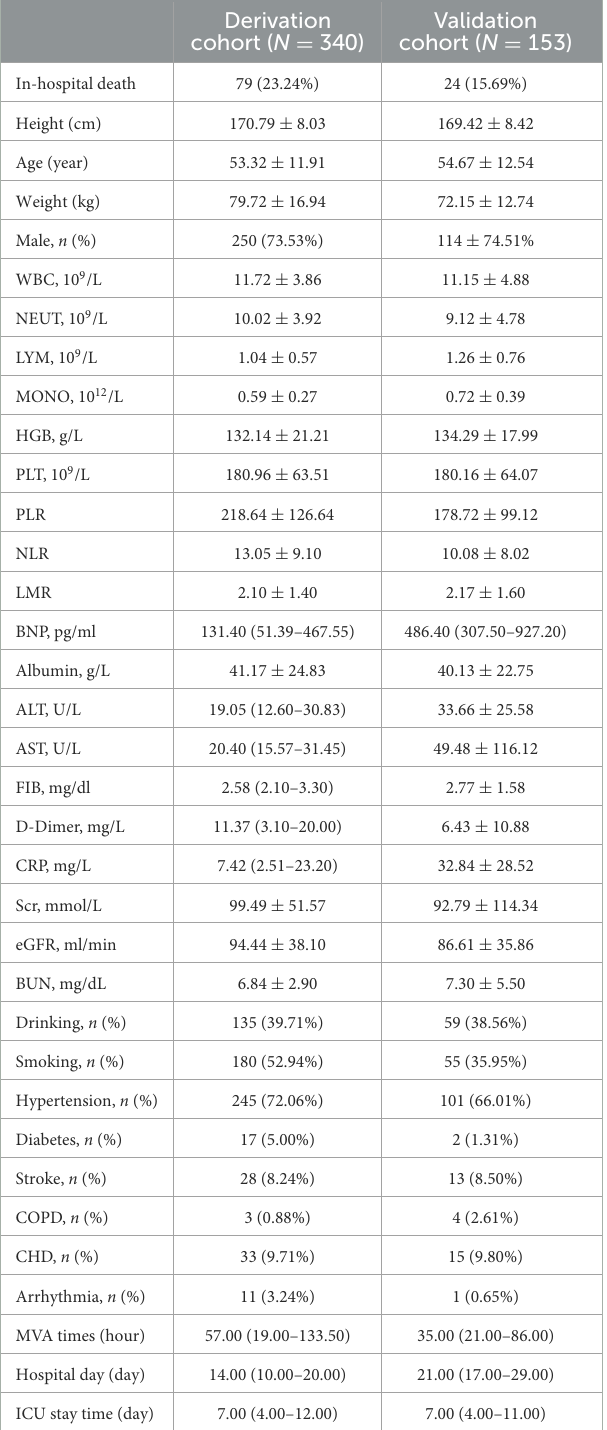
TABLE 2 Patient characteristics and outcomes in derivation and validation